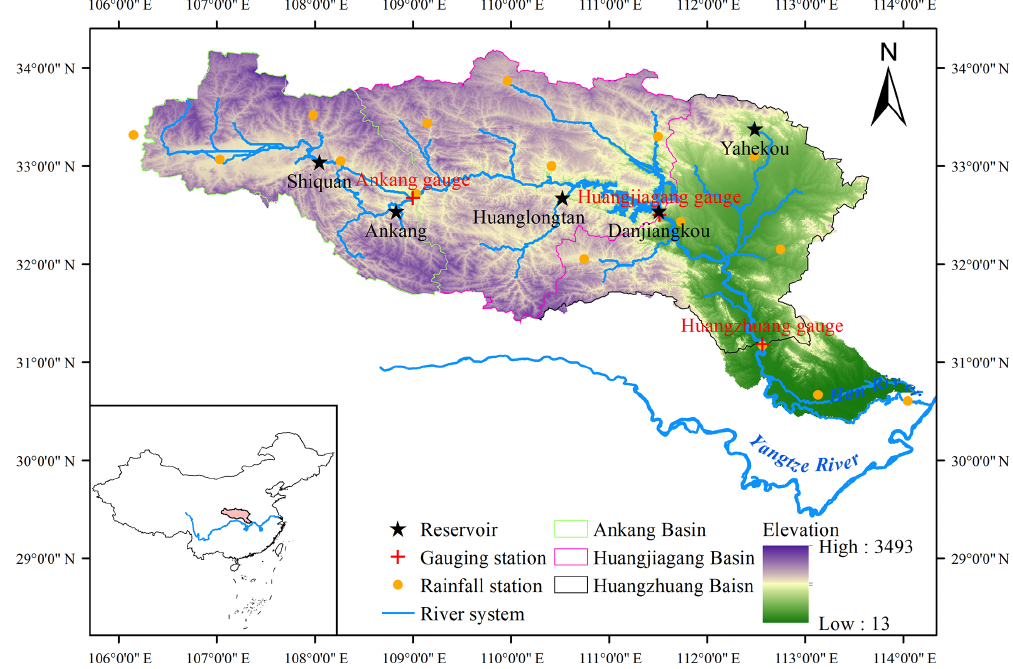
Figure 4. Geographic location of the reservoirs, gauging stations, and rainfall stations along the Han